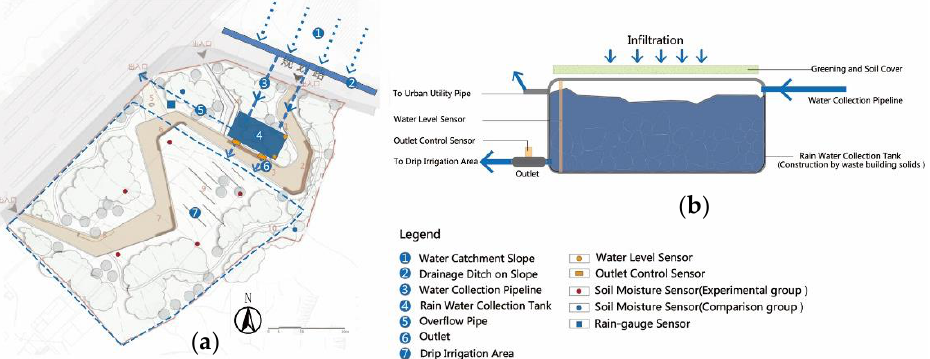
Figure 4. Layout of stormwater management facilities on site ( a ), and a schematic diagram of the water storage facility structure for harvesting and irrigation ( b ).